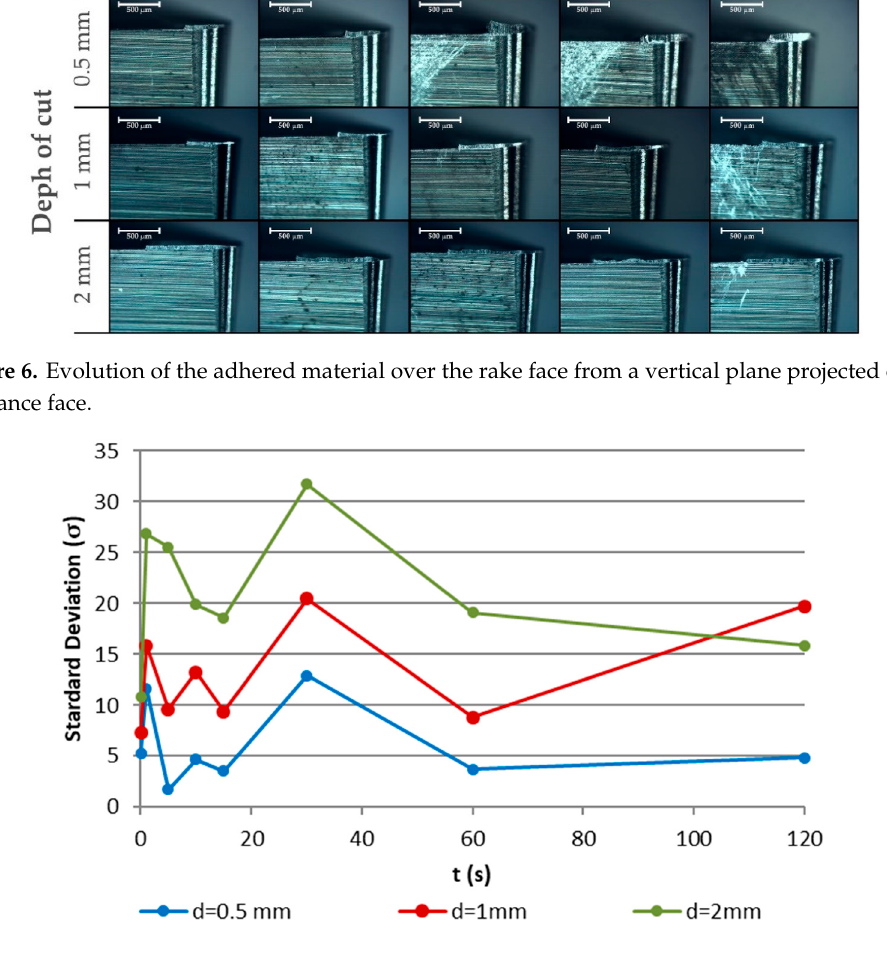
Figure 6. Evolution of the adhered material over the rake face from a vertical plane projected on the clearance face.